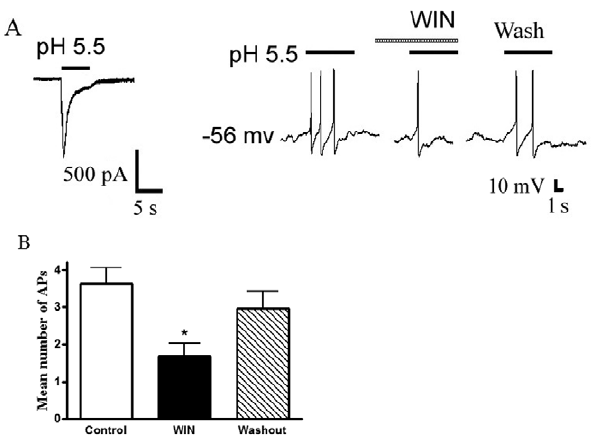
Figure 6. Effect of WIN55,212-2 on proton-evoked action potentials of rat DRG neurons. A. Original current and action potentials recordings from the same DRG neuron. Left panel, pH 5.5 induced an inward current with voltage-clamp recording. Right panel, pH 5.5 produced action potentials with current-clamp recording in the same neuron. The pretreatment of WIN55,212-2 (WIN, 10 2 7 M) decreased the acid-induced the number of action potentials. B. Bar graph shows the effect of WIN55,212-2 on the number of action potentials produced by pH 5.5 acid perfusions. After 30 min washout of WIN55,212-2, acid-evoked action potentials recovered to control condition. *P , 0.05, paired t-test, compared with control, n=8/each